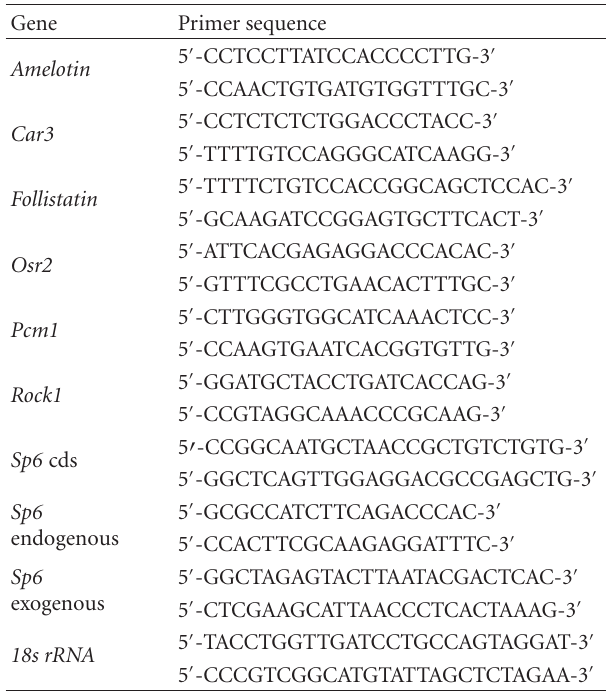
Table 1: Gene-specific